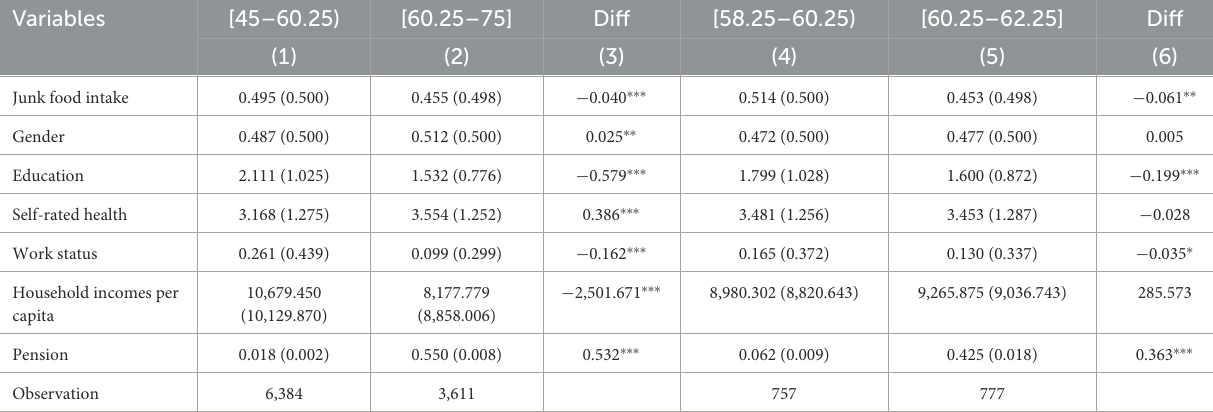
TABLE 2 Subgroup